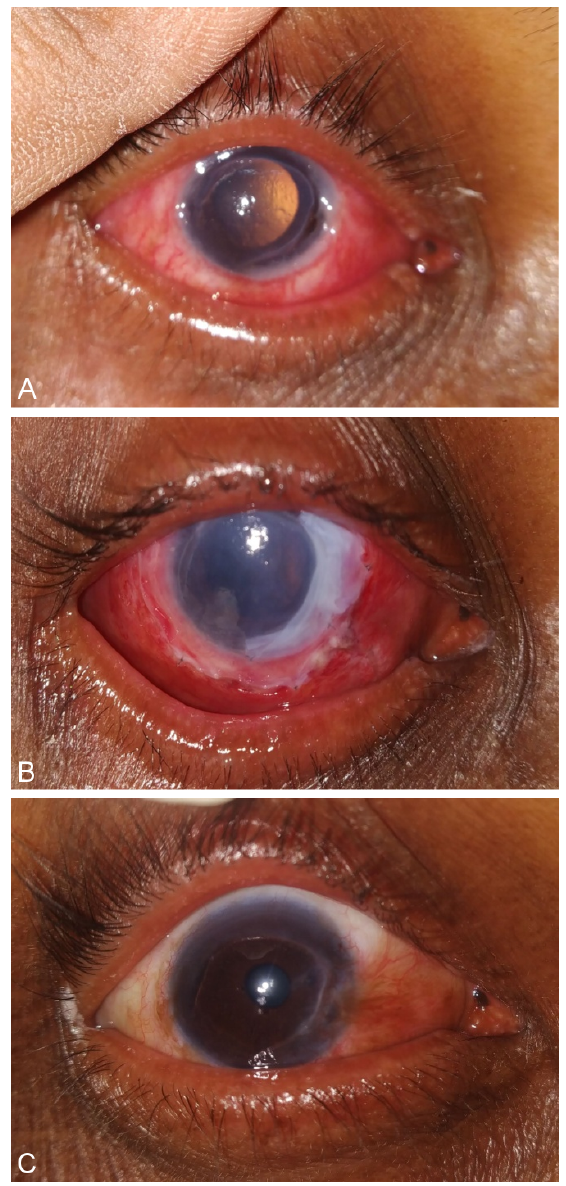
Figure 1: (A) Pre-operative picture of RE showing Mooren’s ulcer with impending perforation; (B) post-operative day 1; (C) post-operative 1 month Investigations including hemogram with ESR, RBS, urine routine and microscopy, VDRL, RA factor, HCV, X-ray chest and joints, SGPT, ANCA, ANA, and HBsAg were